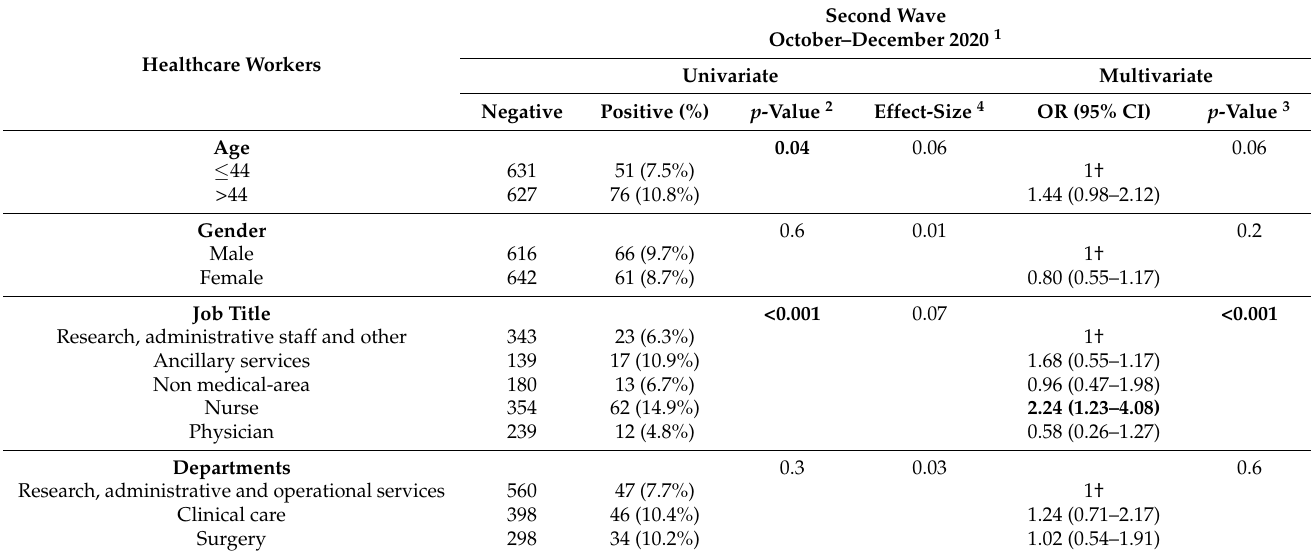
Table 4. Univariate and multivariate analysis in the second pandemic wave for HCWs (Healthcare Workers).